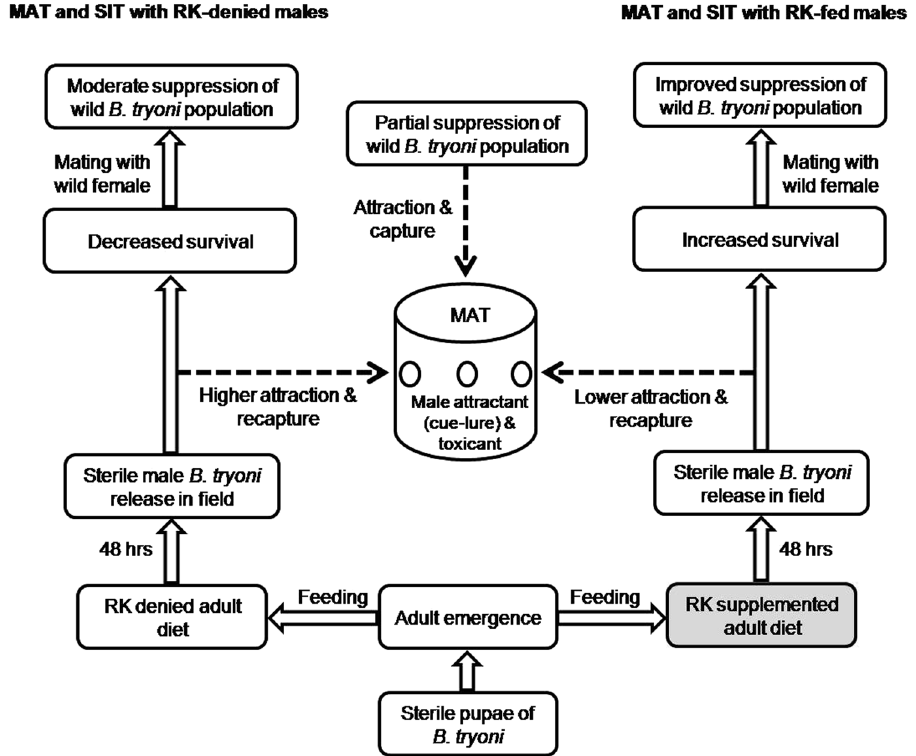
Figure 3. The comparative advantages of pre-release raspberry ketone (RK) supplementation of the immature sterile adult Bactrocera tryoni diet in sterile insect technique (SIT) programs which incorporate the use of the male annihilation technique (MAT), resulting in increased sterile male survival and a reduced response to MAT, and therefore increased suppression of wild B. tryoni